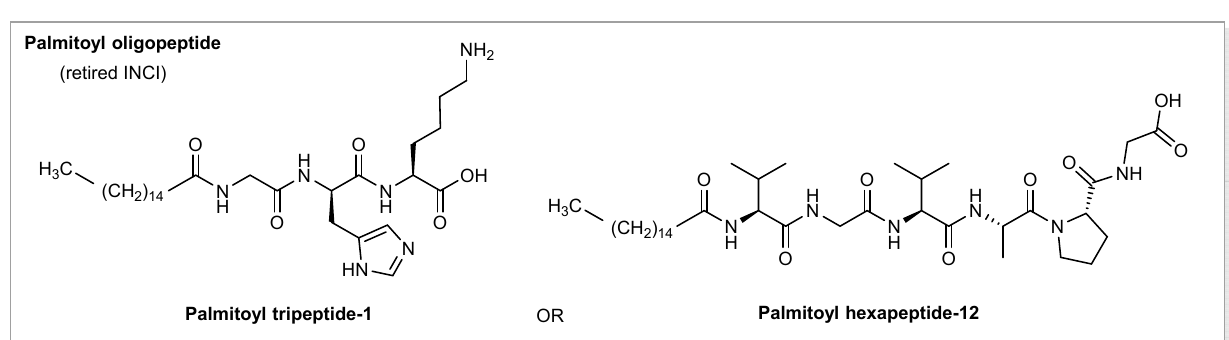
Figure 1. Structures of peptides found at INCI lists from cosmetic products for sensitive skin.